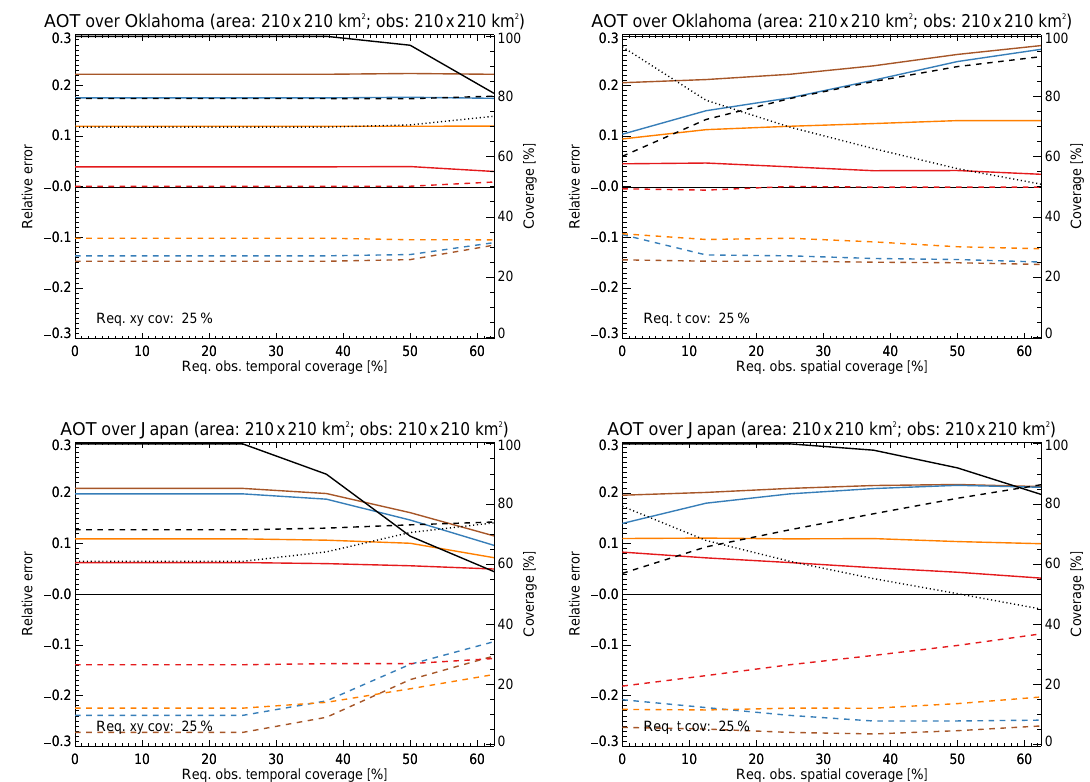
Figure 14. Monthly mean (dashed) and RMS (solid) of representation errors for an imager on a polar-orbiting satellite as a function of required spatial or temporal coverage of the observations. Results are shown for no collocation (brown), no collocation but using super- observations (dark blue), collocation to the day (orange) and finally model data collocated to the hour (red). Results for a repeat cycle of 1 day. Further explanation in Sect. 3.2.